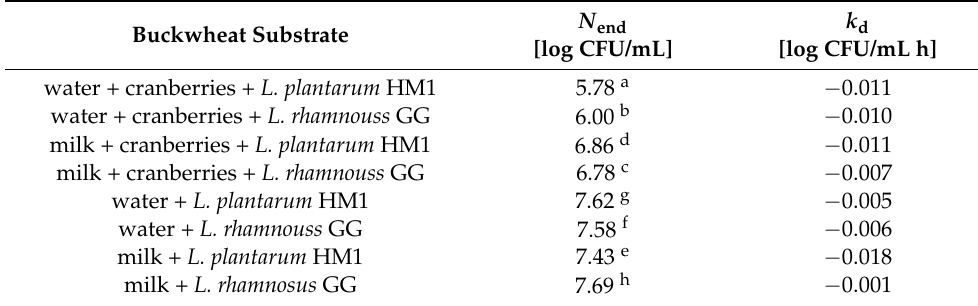
Table 1. Parameters evaluating behavior of L. plantarum HM1 and L. rhamnosus GG at 6 ± 0.5 ◦ C for 14 days added after fermentation (8 h). Buckwheat Substrate